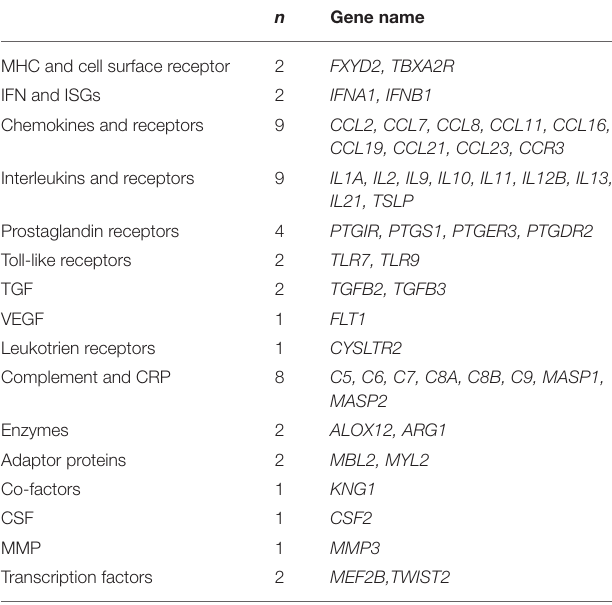
TABLE 2 | List of undetected inflammatory genes in conjunctival cells from CI samples collected in DED patients.